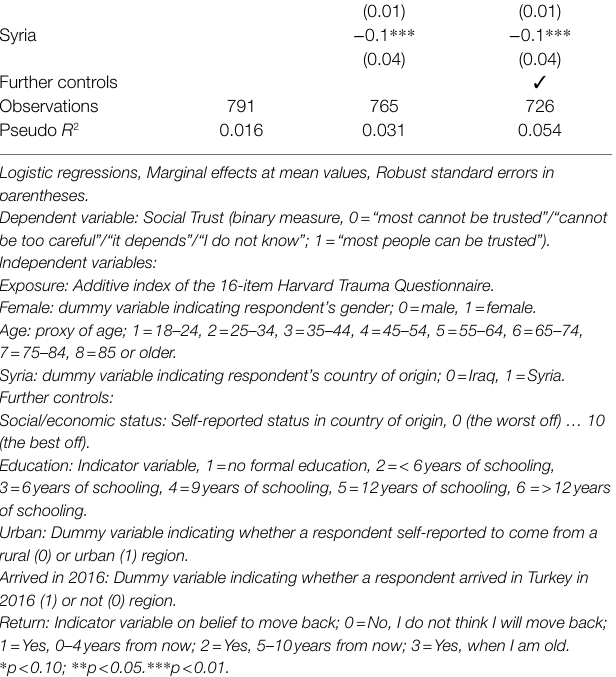
Dep. variable: Social Trust Marginal Effects